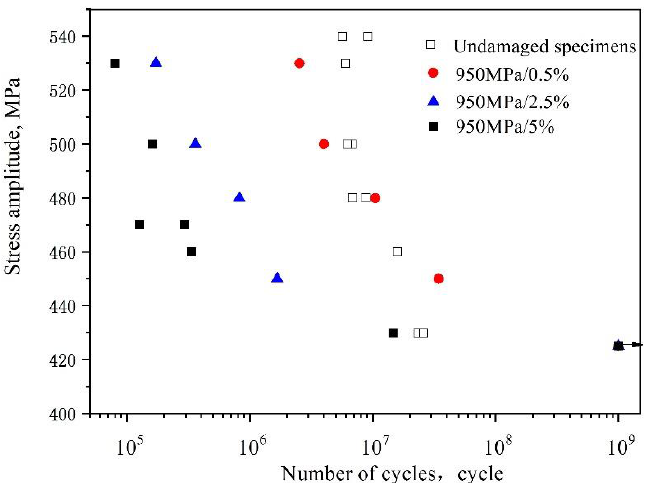
Figure 2. S-N curves of predamaged specimens for TC21 titanium alloy (arrows denote the run-out